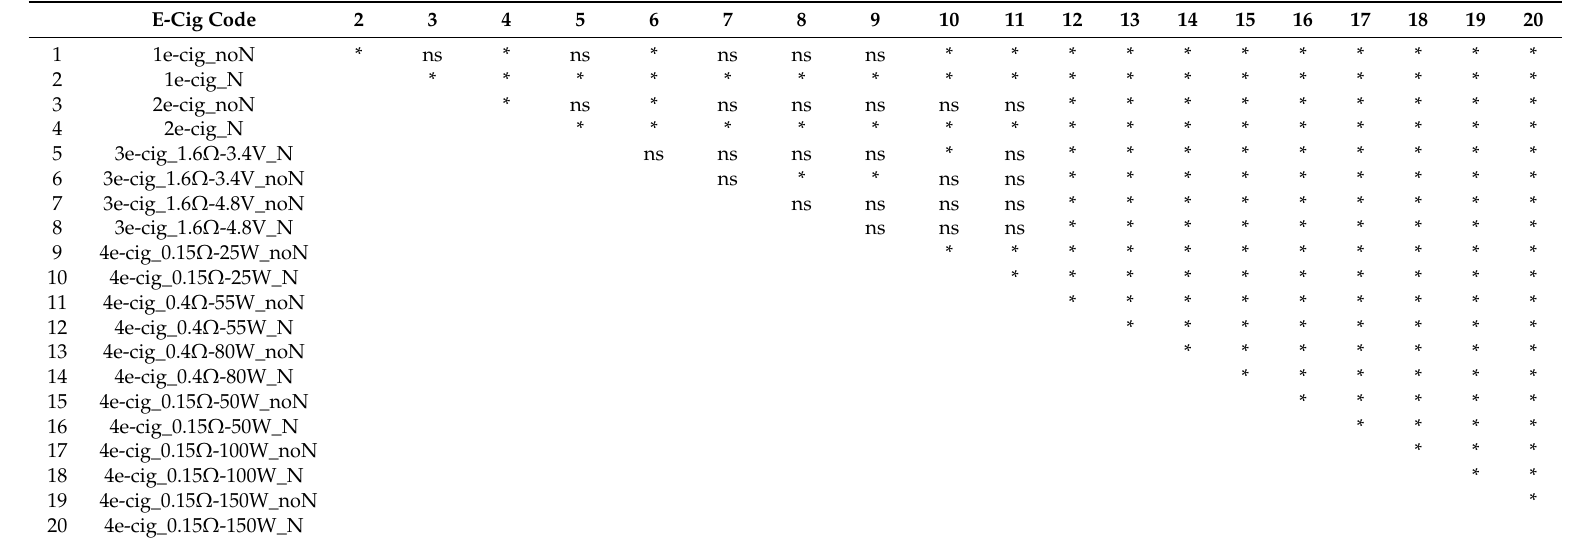
Table 3. Pairwise post-hoc tests carried out considering each monitored setting